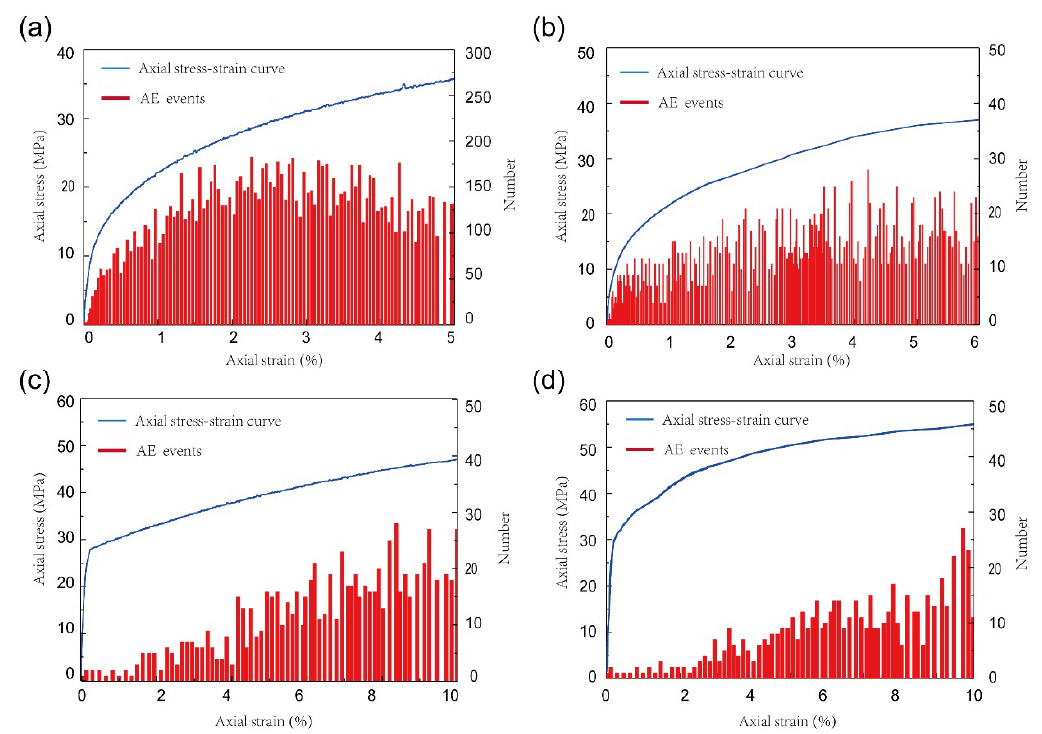
Figure 6. AE event number of rock salt under different confining pressure during the triaxial loading test: ( a ) confining pressure of 5 MPa; ( b ) confining pressure of 10 MPa; ( c ) confining pressure of 15 MPa; and, ( d ) confining pressure of 20 MPa.